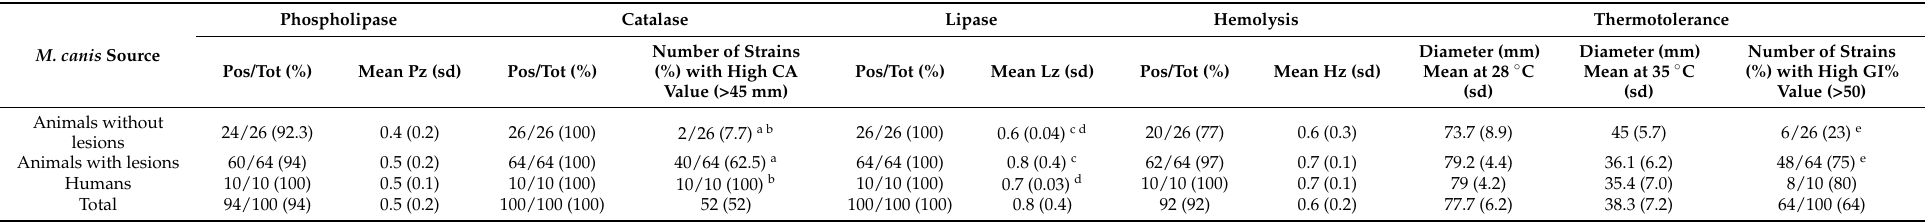
Table 1. Number (Positive/Total) and percentage (%) of Microsporum canis strains presenting phospholipase (Pz), catalase (Ca), lipase (Lz), hemolytic (Hz) activities, and thermotolerance (GI) according to their origin (animals with and without lesions and humans). The Pz, Lz, and Hz activities were expressed as mean values with standard deviation (sd) in bracket. Ca and GI were reported as the number and percentage (%) of strains producing high values.